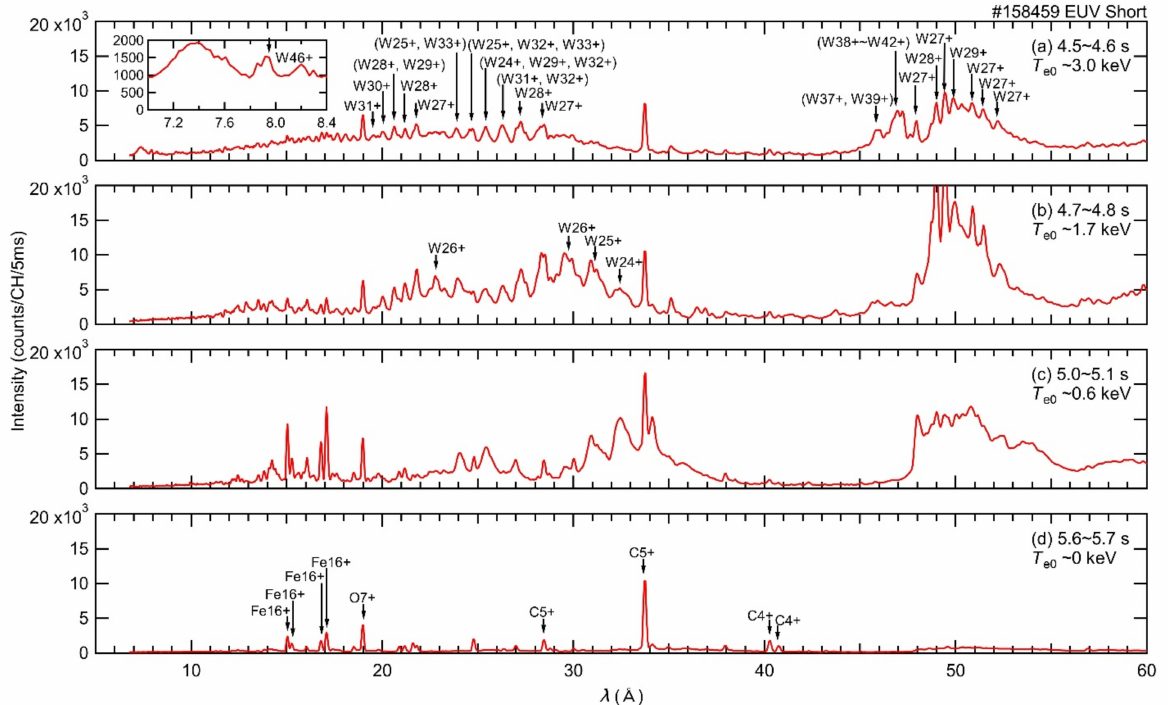
Figure 7. EUV spectra including W 24+ –W 42+ UTA and W 46+ line emissions in the wavelength range of 5–60 Å measured using “EUV Short” spectrometer with T e 0 for each timing of data acquisition. ( a ) 4.5~4.6 s, T e 0 ~3.0 keV, ( b ) 4.7~4.8 s, T e 0 ~1.7 keV, ( c ) 5.0~5.1 s, T e 0 ~0.6 keV, ( d ) 5.6~5.7 s, T e 0 ~0